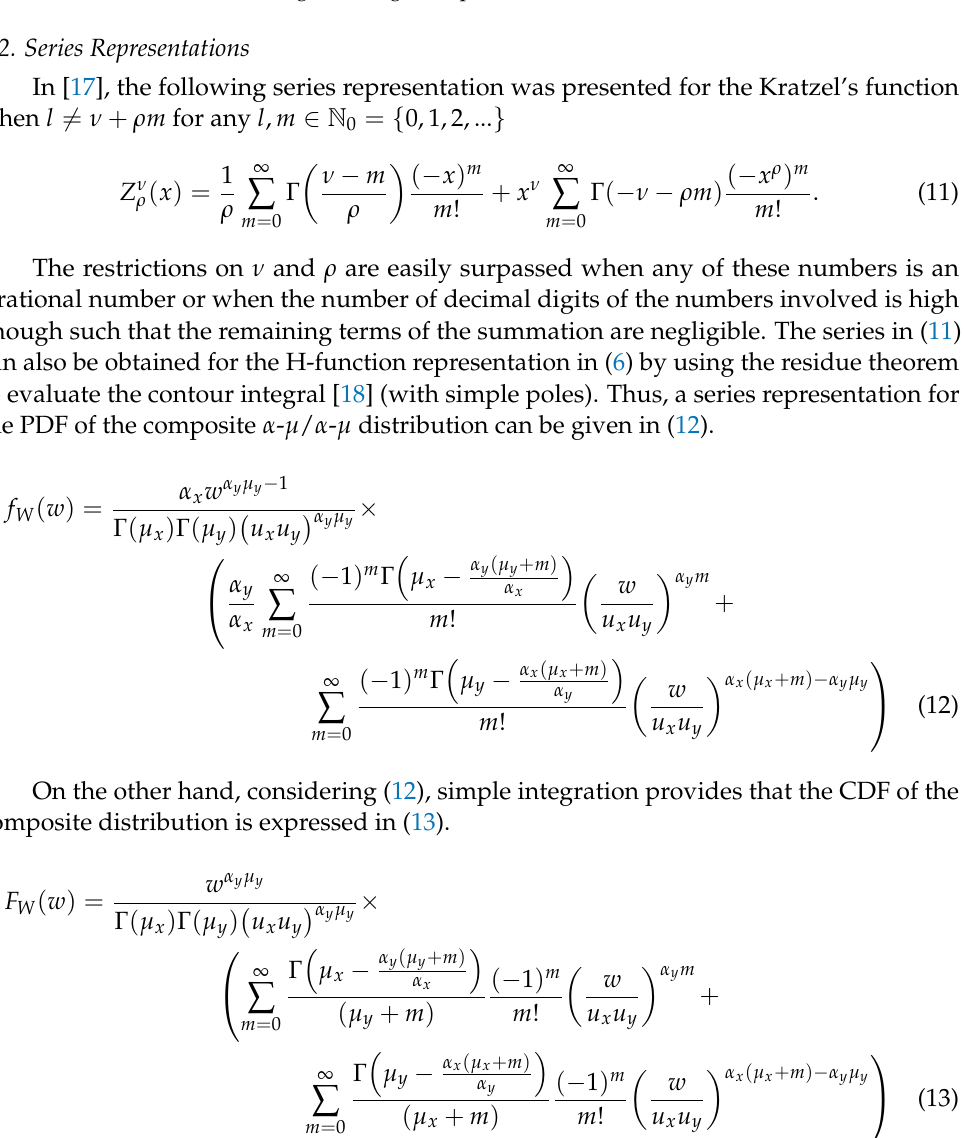
Figure 2. PDFs and CDFs Plotted Using the Integral Representations